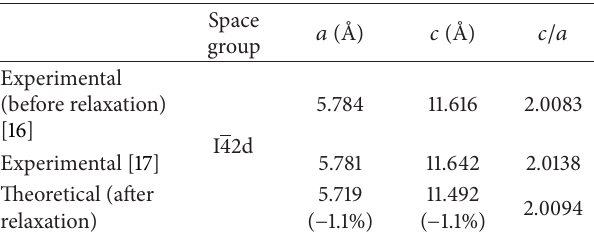
Table 1: The theoretical lattice parameters 𝑎 , 𝑐 , and 𝑐/𝑎 of CIS unit cell and the experimental values.